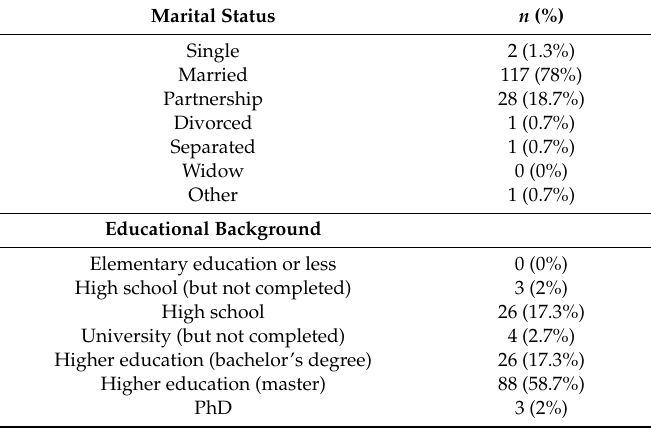
Table 1. Descriptive characteristics of the study group ( n = 150). APGAR: (A-appearance (skin